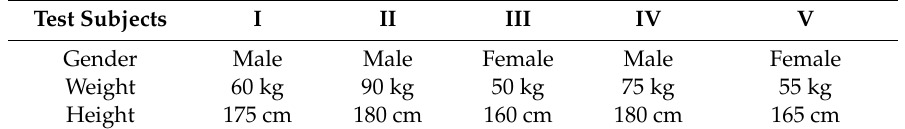
Table 2. The gender, weight, and height of the test subjects.